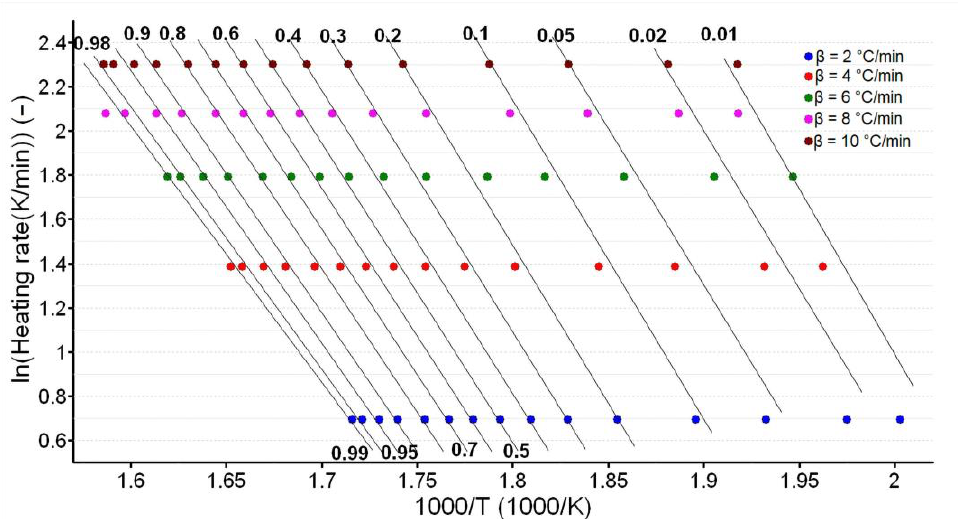
Figure 8. Flynn – Wall – Ozawa linear plotting for decomposition of EE. Figure 8. Flynn–Wall–Ozawa linear plotting for decomposition of